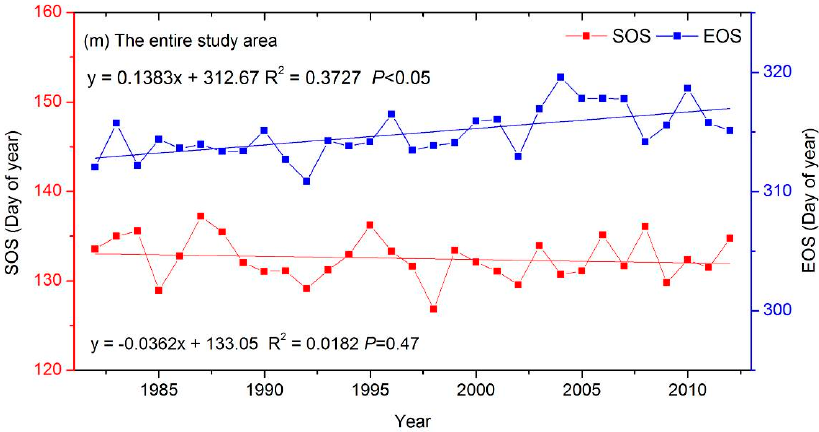
Figure 4. Interannual variabilities of the SOS and EOS in different ecoregions. ( a ) is the low-hill larch and broadleaf forest and artificial vegetation in eastern Liaoning and Shandong (LLS) ecoregion area; ( b ) is the larch and broadleaf forest areas in the mountains of North China (LMN) ecoregion area; ( c ) is a grassland area in the Xiliaohe Plain (GXP) ecoregion area; ( d ) is grassland area at the southern end of the Greater Khingan Mountains (GGM) ecoregion area; ( e ) is the forest grassland area in the center of the Songliao Plain (FXP) ecoregion area; ( f ) is the plain grassland area in the Hulunbuir plain (PHP) ecoregion area; ( g ) is the coniferous and broadleaf mixed forest area in the eastern piedmont tableland of the Songliao Plain (CSP) ecoregion area; ( h ) is the wetlands of the Sanjiang Plain (WSP) ecoregion area; ( i ) is the forest grassland area on the western side of the northern segment of the Greater Khingan Mountains (FGM); ( j ) is the mountain grassland forest area in the middle segment of the Greater Khingan Mountains (MGM) ecoregion area; ( k ) is the coniferous forest area in the Changbai Mountains in the Lesser Khingan Mountains (CLM) ecoregion area; ( l ) is the larch and coniferous forest area in the northern segment of the Greater Khingan Mountains (LGM) ecoregion area; ( m ) is the entire study area of Northeast China (NEC). Table 1. Linear trends of the SOS and EOS in different ecoregions of Northeast China. Trends (Days/Year) Ecoregions SOS